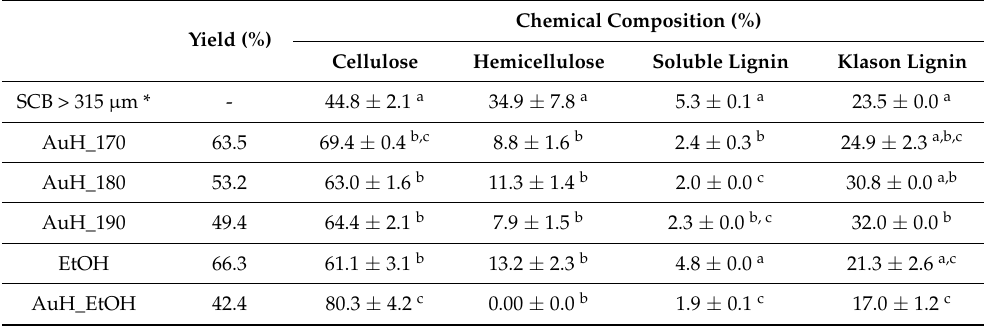
AuH_EtOH 17.0 ± 1.2